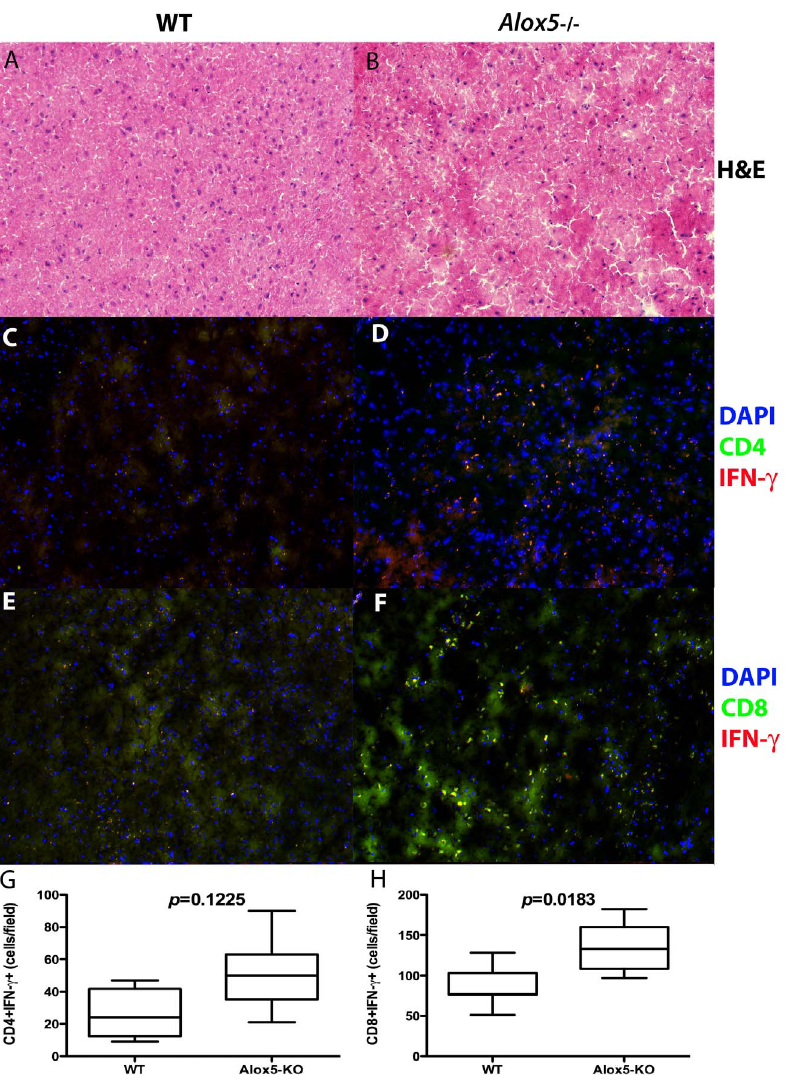
Figure 4. Increased inflammation and CD8 + IFN- c + cells in brains from P.berghei ANKA-infected Alox5 2 / 2 mice. C57Bl/6 WT (A, C and E) and Alox5 2 / 2 (B, D and F) ( n =4 mice/group) mice were infected i.p. with P. berghei ANKA strain. At 5 days after infection, animals were sacrificed, brains harvested and tissue sections obtained. Panels A and B show H&E micrographs. C and D show immunofluorescence staining for CD4 (green) and IFN- c (red). E and F show staining for CD8 (green) and IFN- c (red). DAPI was used as a counterstain ( C–F ). Double-positive (CD4 + IFN- c + 2 G , and CD8 + IFN- c + 2 H ) cells were quantified using ImageJ software. Magnification 200x. Statistical analysis in data from panels E and F was performed using Mann-Whitney